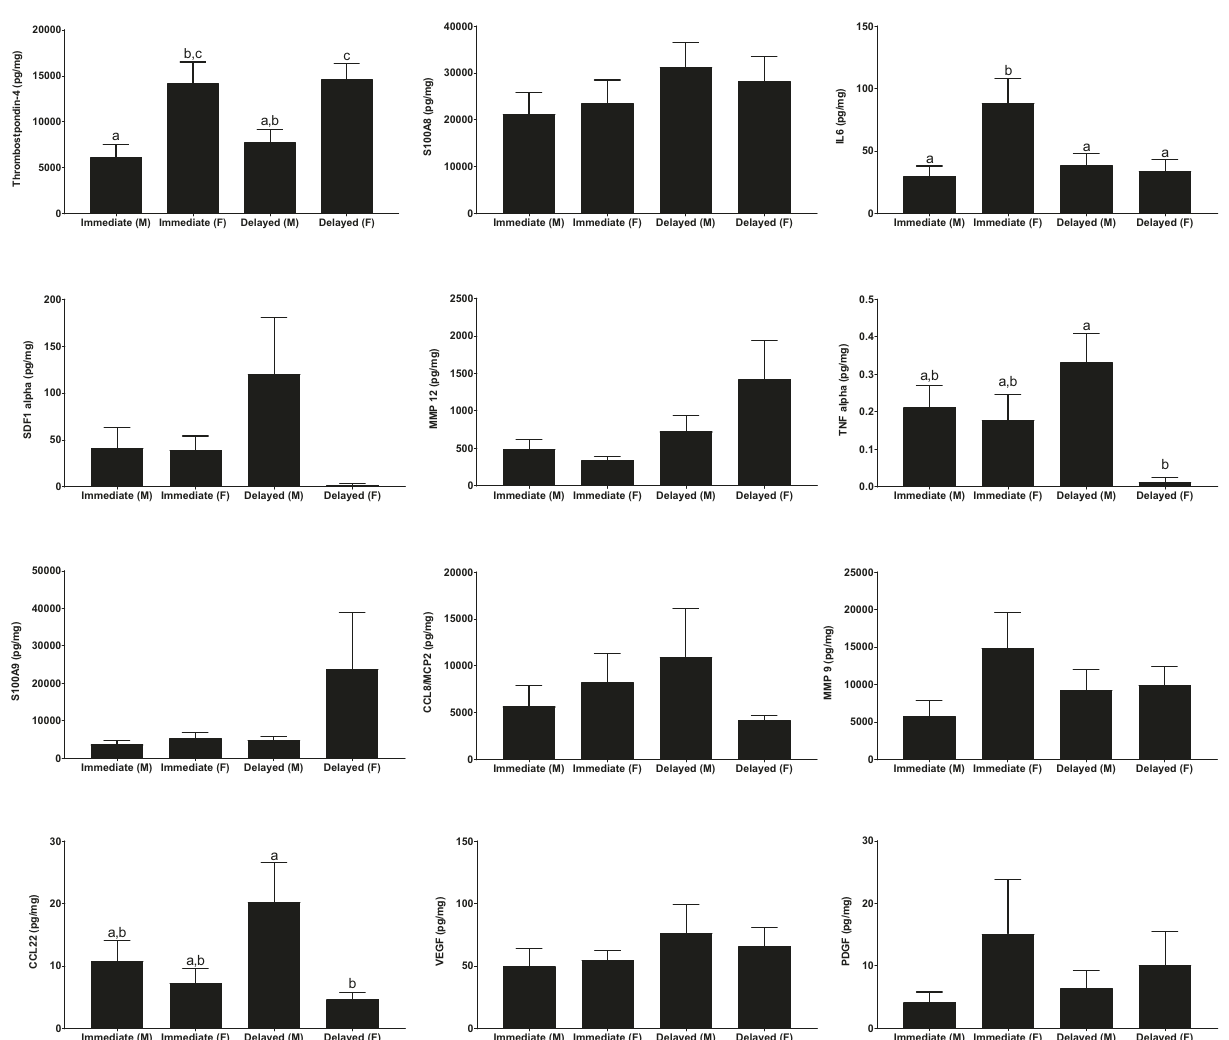
Fig. 3 Delay in the repair of the nerve after peripheral nerve injury signi fi cantly alters the expression of in fl ammatory and ECM remodeling proteins. IL6, SDF1-alpha, and TNF-alpha were signi fi cantly reduced in female animals; whereas MMP-12 was signi fi cantly elevated in both sexes. Protein expression determined by Luminex assay and standardized to total protein level with a 5-mm inert silicone conduit inserted at the sciatic repair site. Signi fi cance was determined by ANOVA and. Groups not connected by the same letter are signi fi cantly different (Tukey post hoc test, P < 0.05). Letters not shown if ANOVA P > 0.05. n = 12 per group per IL10 as a potential target for modulation of the macrophage response to delayed repair Further examination of macrophage gene expression data at the peak of macrophage in fi ltration (5 days after repair) identi fi ed a mix of pro-in fl ammatory and anti-in fl ammatory genes known to be expressed by macrophages at the site of nerve repair (Supplemental Fig. 3) 48 – 52 . In prior work, we had identi fi ed IFN ɣ as a key upstream regulator of temporal changes in macrophage gene expression 50 . As IFN ɣ is downregulated by IL10, and IL10 was the anti-in fl ammatory gene with the highest differential expression (Supplemental Fig. 3a), we next exam- ined the effect of IL10R deletion on macrophage gene expression in mice with a myeloid-speci fi c deletion for IL10ra and demonstrated a signi fi cant increase in pro-in fl ammatory and angiogenic genes such as IL6, Saa3, and Cd31 when IL10ra was absent (Supplemental Fig. 3b). These data suggest that downregulation of IL10 in delayed repair may have a marked effect on macrophage expression of other in fl ammatory cytokines at the repair site.